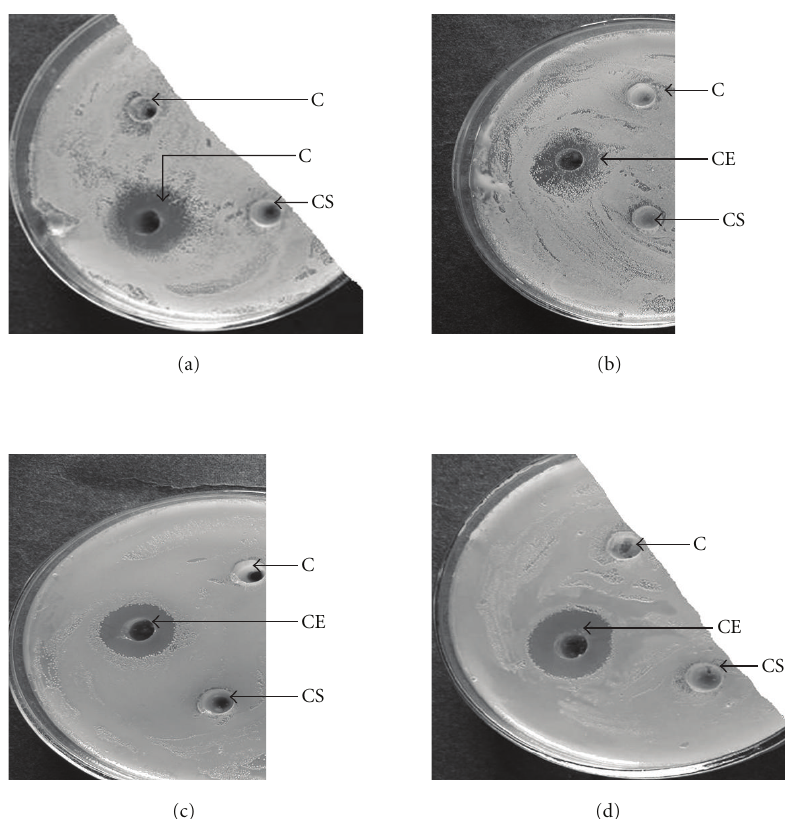
Figure 6: Antibacterial activity of the crude cell extract of the Aeromonas hydrophila strain An4 on indicator bacteria. (a) Staphylococcus arlettae strain An1, (b) Acinetobacter sp. strain An2, (c) Vibrio parahaemolyticus strain An3, and (d) Alteromonas aurentia strain SE 3. C: control (Ethyl acetate); CE: cell extract; CS: culture supernatant.